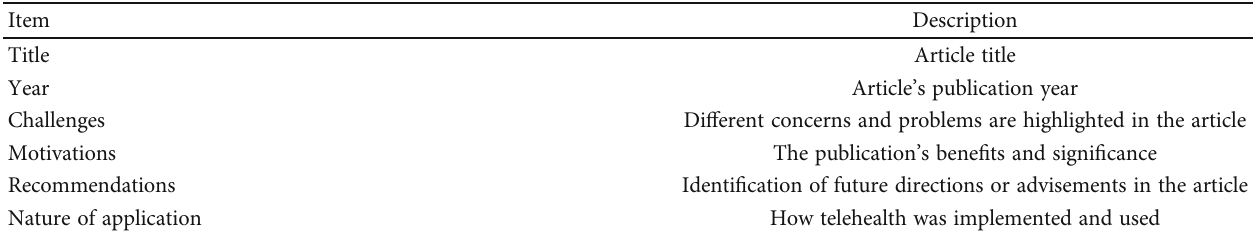
Table 1: Data extraction and classi fi cation contents.